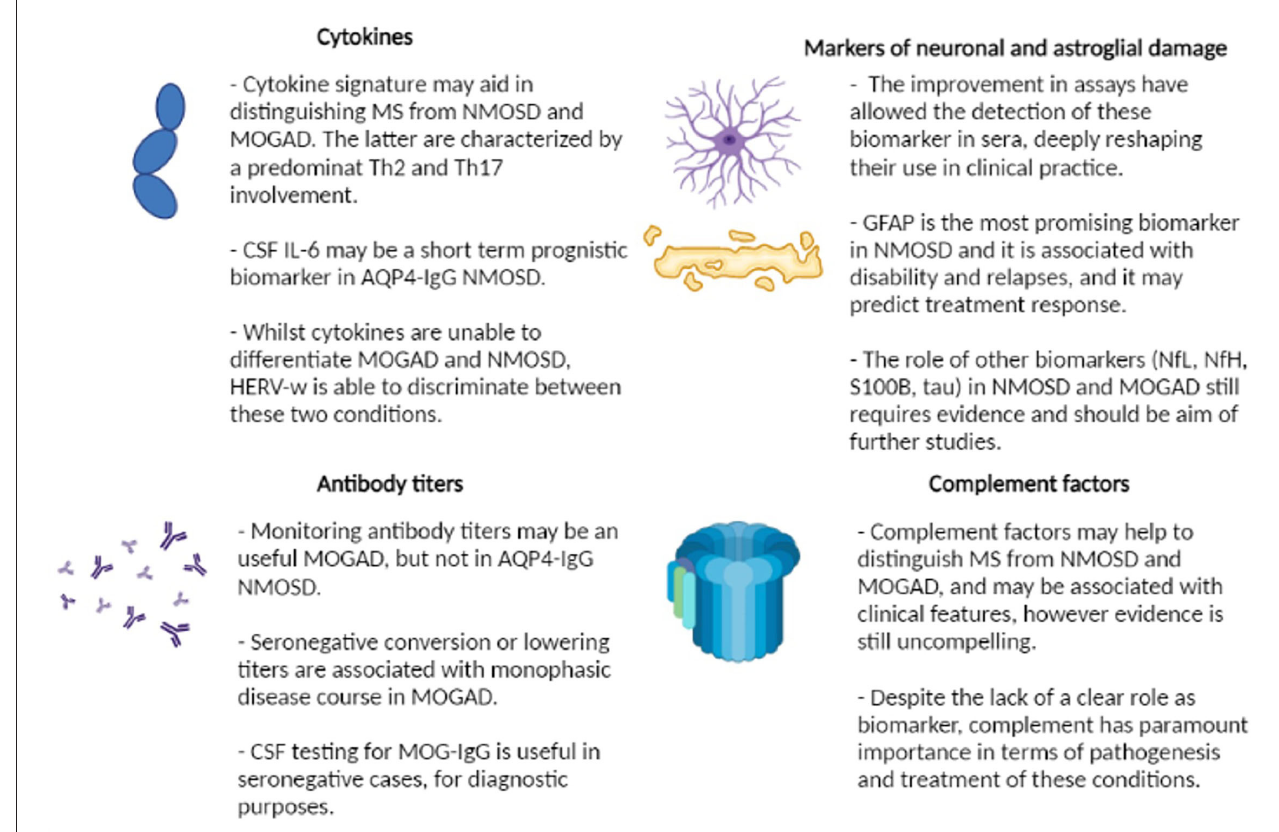
FIGURE 2 | Summary of current evidence regarding the role of biomarkers in neuromyelitis optica spectrum disorder (NMOSD) and myelin oligodendrocyte glycoprotein associated disorder (MOGAD). MS, multiple sclerosis; Th, T-helper; CSF, cerebrospinal fluid; IL-6, interleukin-6; AQP4-IgG, aquaporin4 antibodies; HERV-w, human endogenous retroviruses; MOG-IgG, myelin oligodendrocyte glycoprotein antibodies; GFAP, glial fibrillary acid protein; NfL, neurofilament light chain; NfH, neurofilament heavy